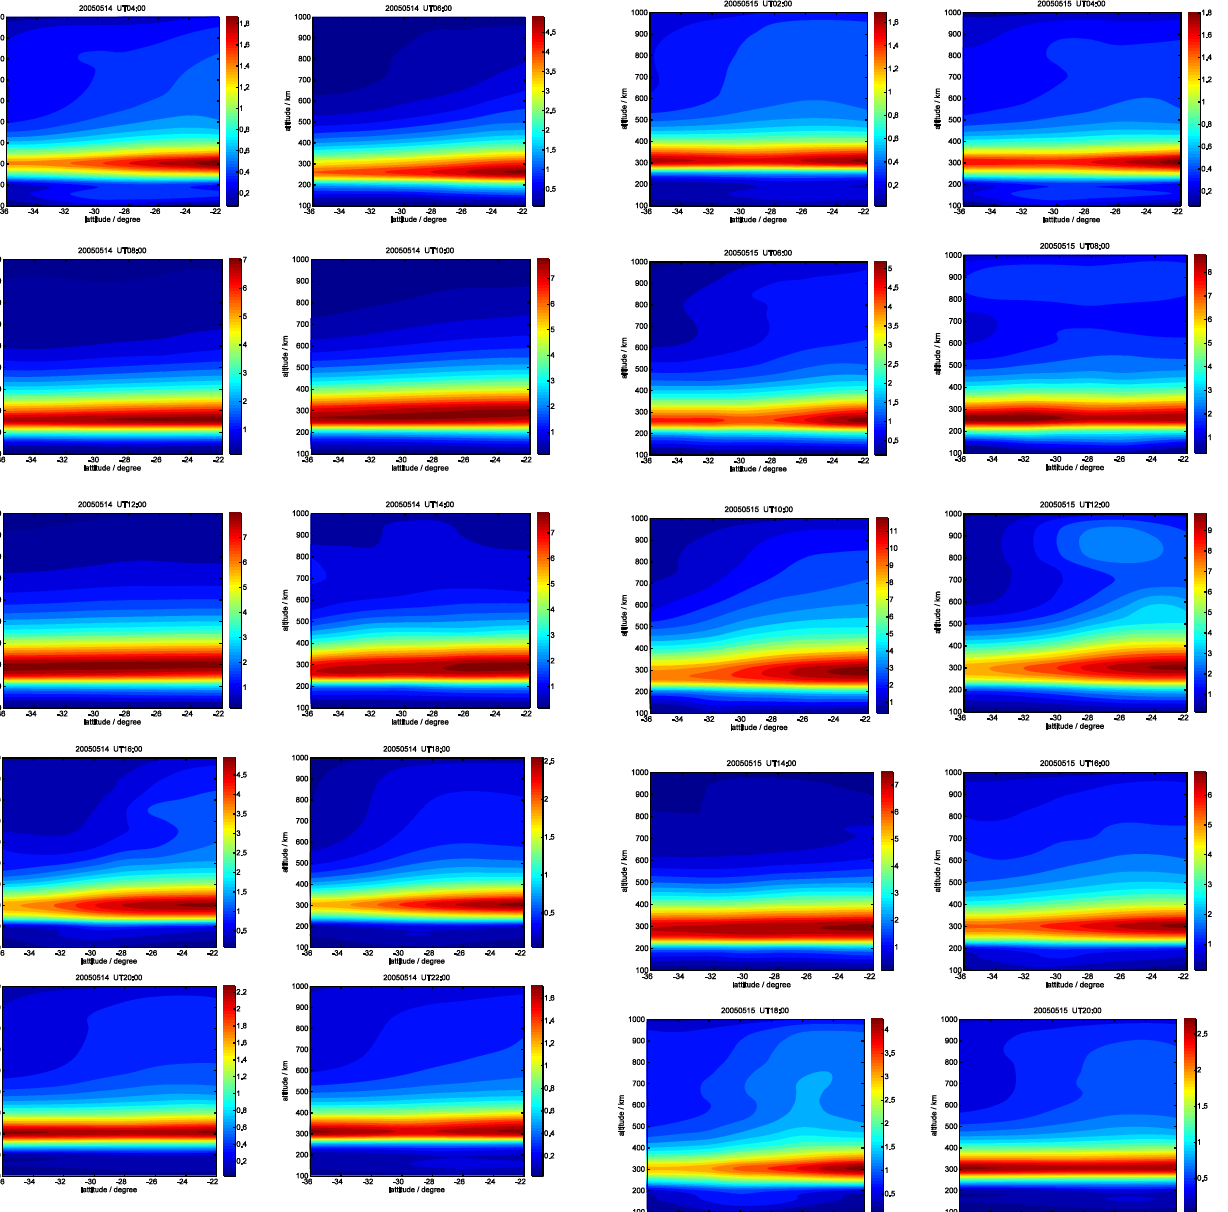
Fig. 5. Map of the electron density changes on the 24 ◦ E pro- file from 04:00UT on 14 May to 20:00UT on 15 May (unit: 10 11 elm − 3 ) .